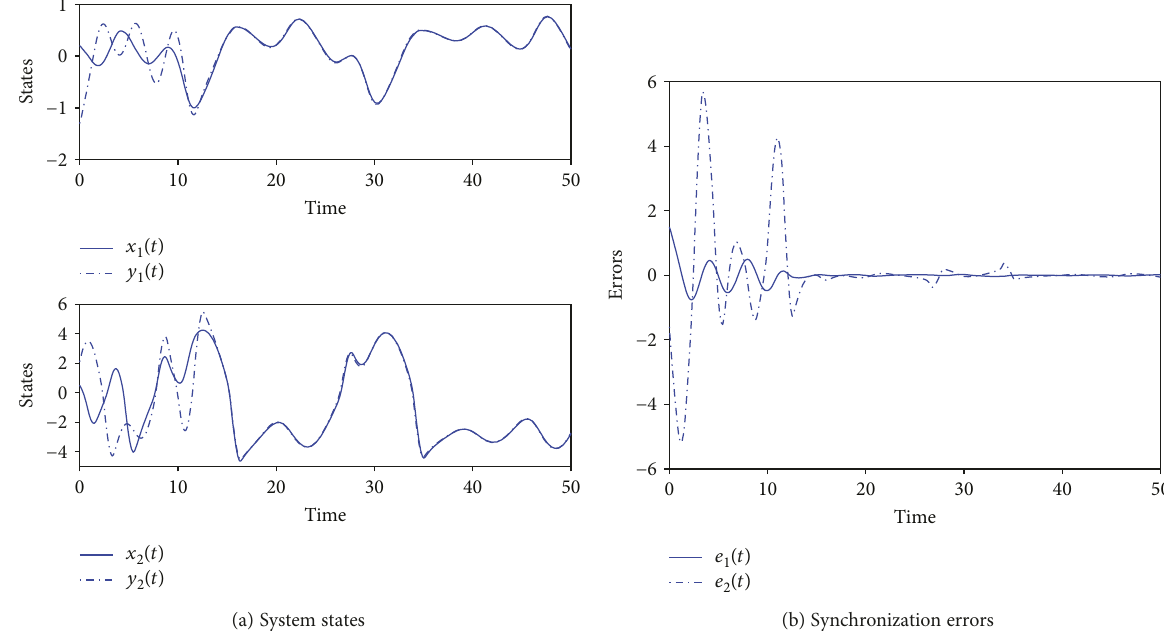
Figure 6: The temporal evolution of each variable and the plot of synchronization errors driven only by the signal x is achieved in Example